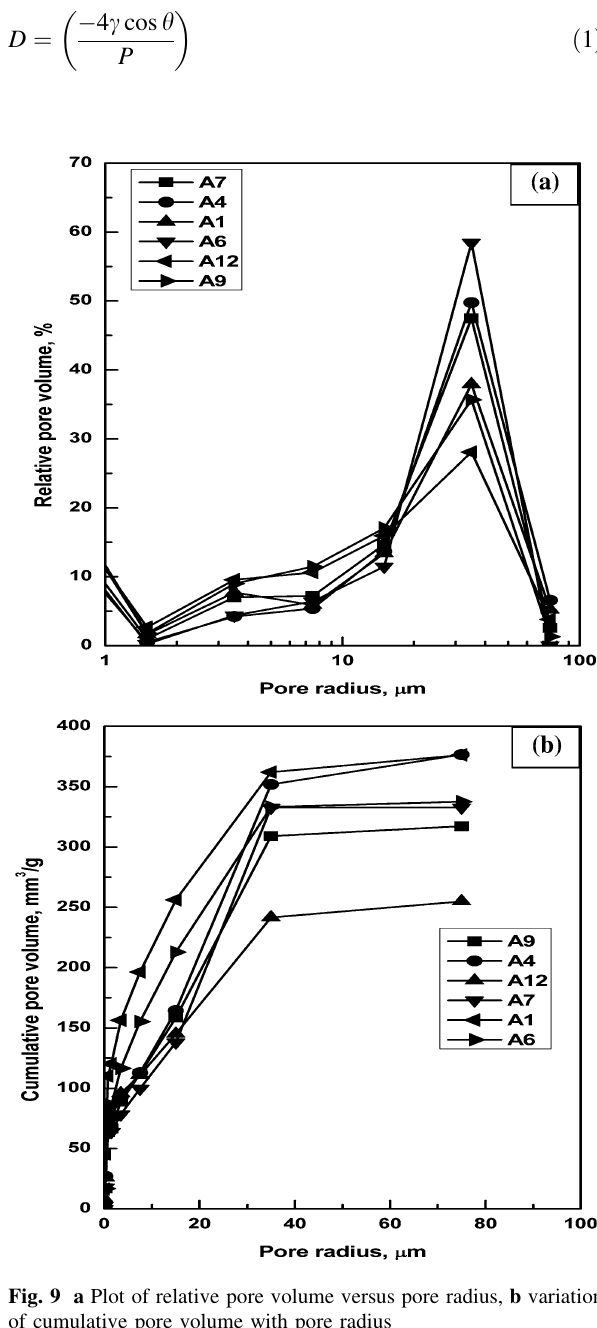
Fig. 8 Comparison of porosity values by different methods